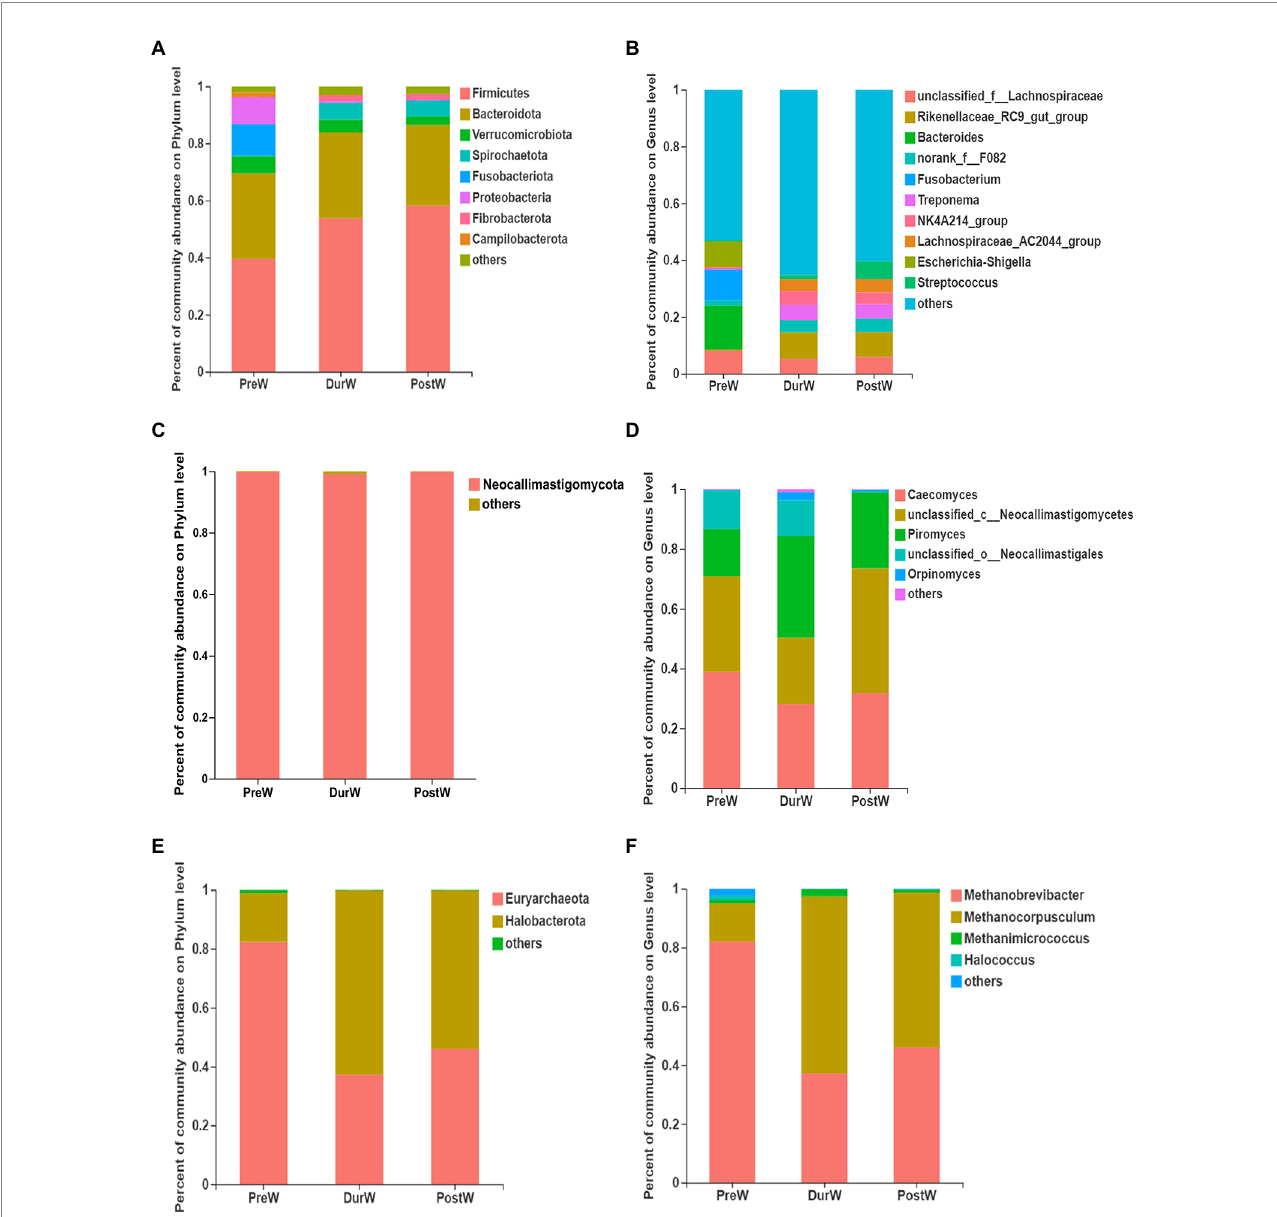
FIGURE 3 Composition of the predominant microbiota among different groups (accounting for ≥ 0.01% of the total sequences in at least one samples). ( A) The predominant bacteria at phylum level. ( B) The predominant bacteria at genus level. ( C) The predominant anaerobic fungi at phylum level. ( D) The predominant anaerobic fungi at genus level. ( E) The predominant archaea at phylum level. ( F) The predominant archaea at genus level; PreW, pre-weaning donkeys; DurW, during weaning donkeys; PostW, post-weaning